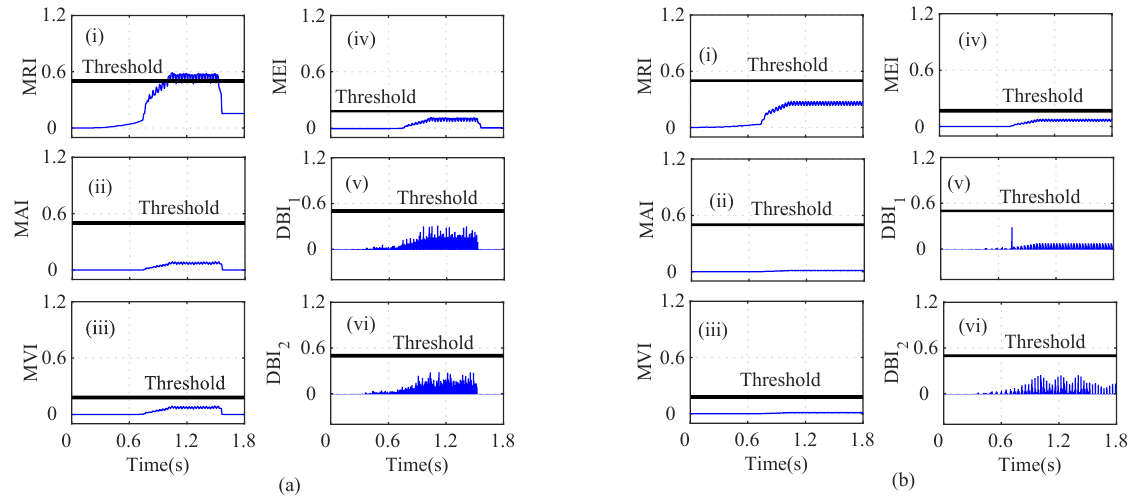
Figure 5. Analysis of residuals for ( a ) ω and ( b ) V α using index-based method ((i) MRI, (ii) MAI, (iii) MVI, (iv) MEI, (v) DBI 1 and (vi) DBI 2 ) for the I α and I β faults at t = 0.739 s and t = 1.52